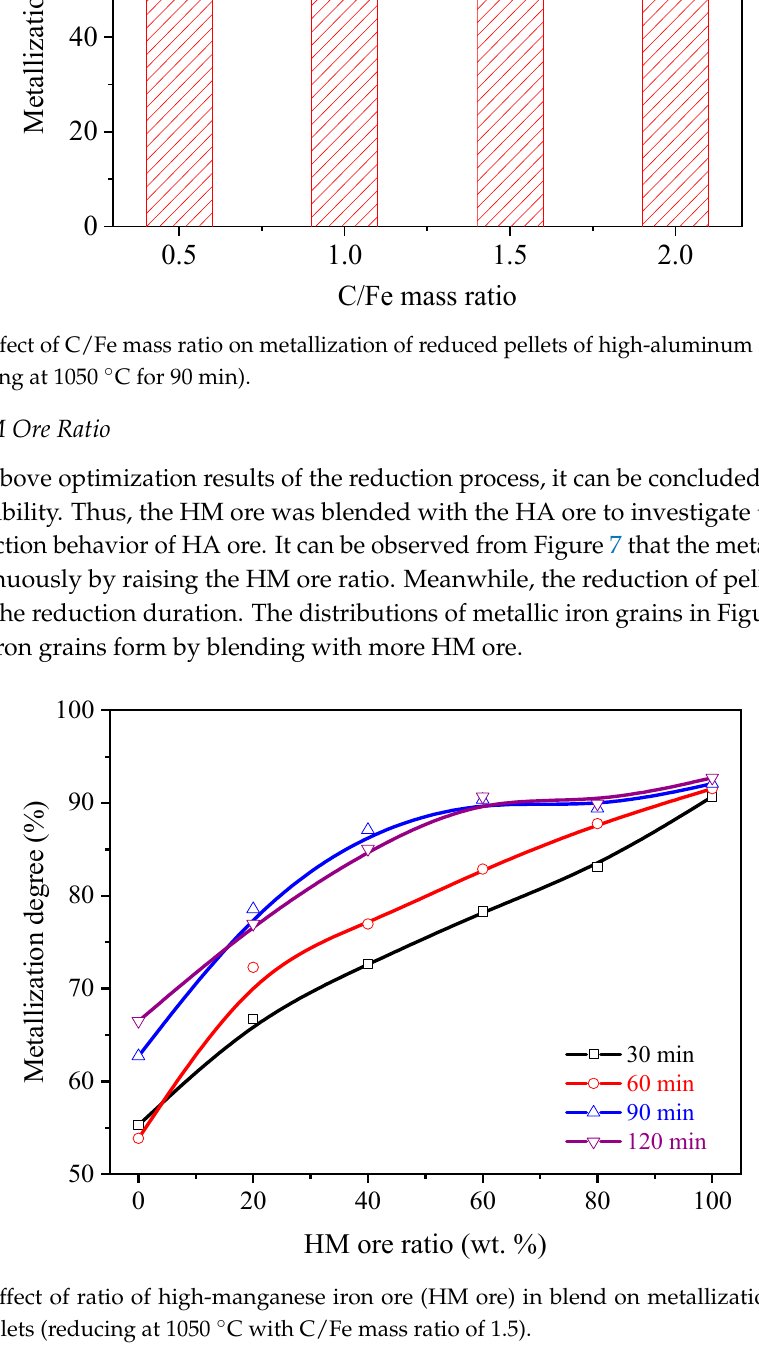
Figure 8. Effect of high-manganese iron ore (HM ore) ratio from 0% to 100% (( a ) ~ ( f )) on distribution of metallic iron grains (white color) in reduced pellets (reducing at 1050 °C for 90 min with C/Fe mass ratio of 1.5). 4. Discussion XRD results of HA reduced pellets under different temperatures are illustrated in Figure 9. Note that fayalite can easily form during the reduction of HA ore. Meanwhile, the diffraction peak intensities of hercynite increase sharply with ascending temperatures, while those of fayalite weaken.